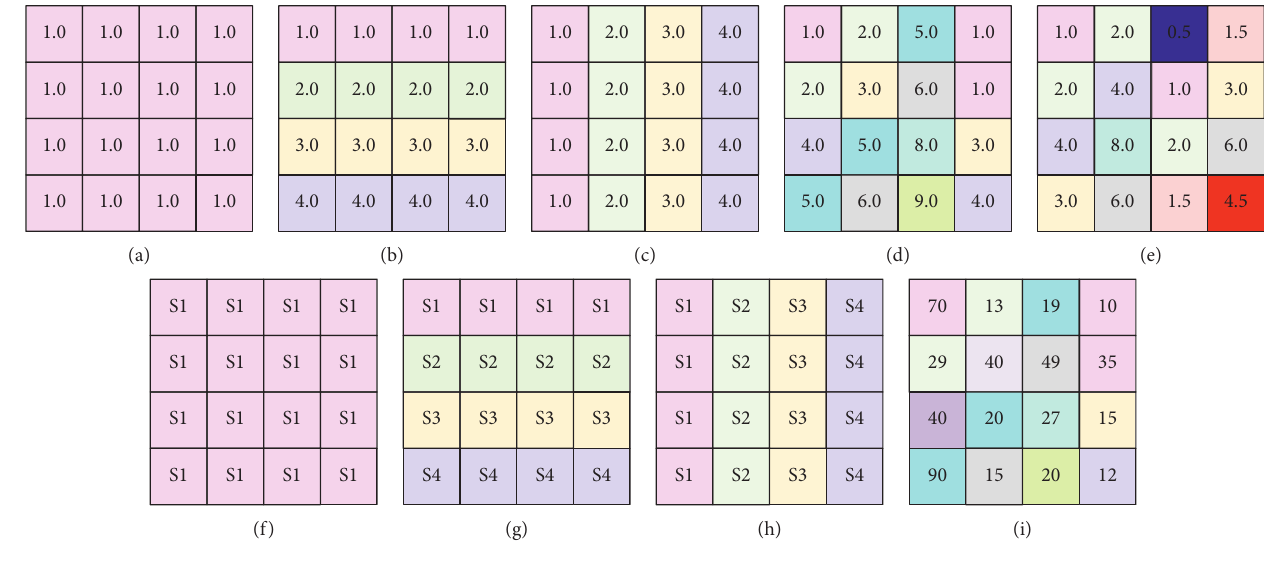
Figure 2: Different types of